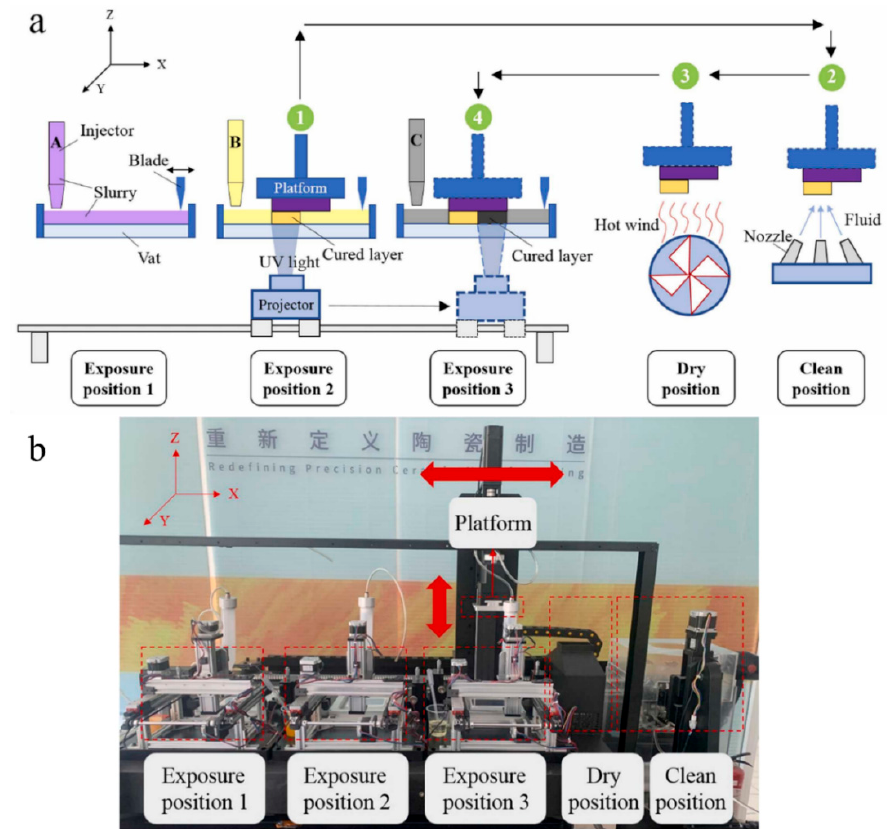
Figure 30. ( a ) Conceptual diagram of multi-material DLP 3D printing setup and ( b ) overview of the actual multi-material DLP 3D printer developed by Hu and co-workers. Reproduced with permission from [63]. Copyright © 2022 Elsevier. Table 5. Multi-material vat photopolymerization.